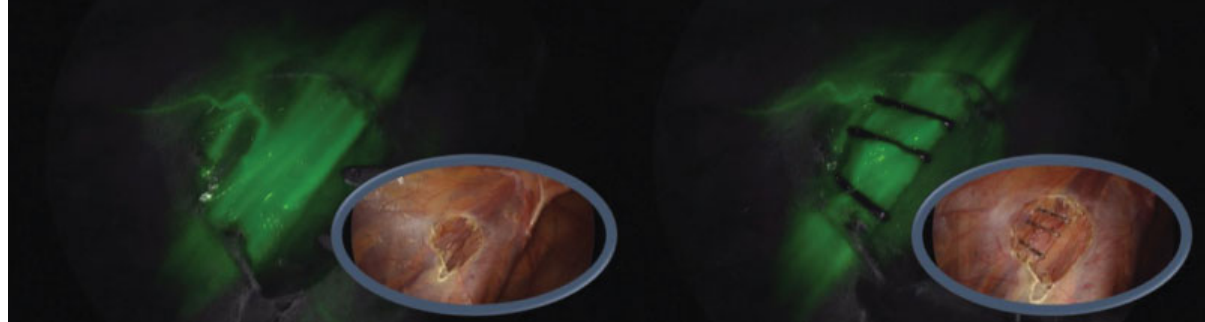
Fig. 2 Ligation of spermatic vessels in varicocele. After the injection of the contrast, the vessels are fi lled (arterial and venous) and its correct ligature is veri fi ed, thanks to the infrared light of the fl uorescence that indicates the vascular tree. European Journal of Pediatric Surgery Reports Vol. 7 No.